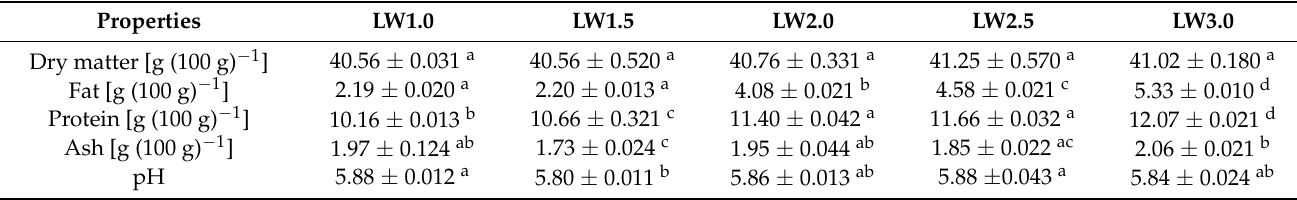
Table 3. Chemical composition of ice cream with the addition of MDB.